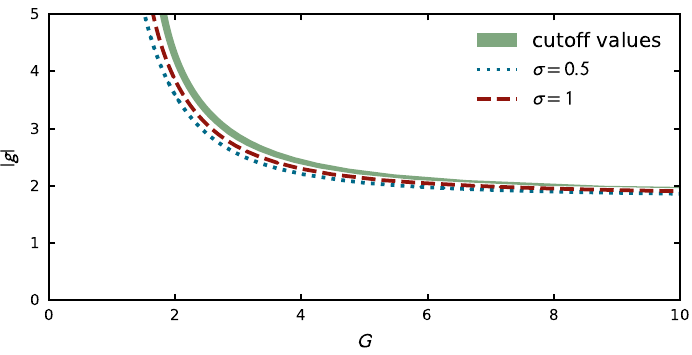
Figure 10: Phase diagram for individual cutoff values. Phase diagram for the 1 ↑ + 1 ↓ vs 1 ↑ + 2 ↓ for individual cutoff values shown by the shaded area. The upper edge of the area shows energies for cutoff 20, the lower edge for cutoff 30 ( g > − 2.0) and 40 ( g < − 2.0). The extrapolated results with the fixed exponent σ = 0.5 ( σ = 1) is shown by the solid blue (dashed red) curve.